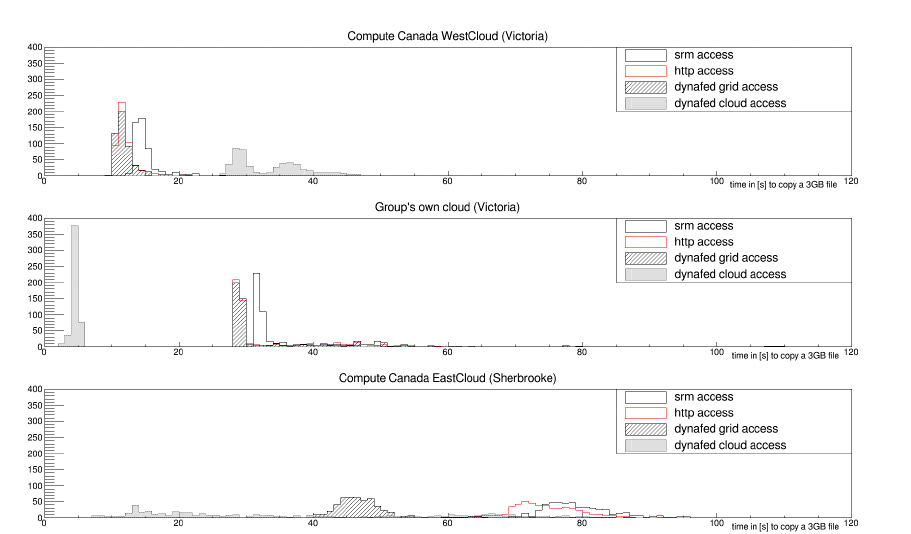
Figure 6: Time distribution for copying 500 3GB files with access through Dynafed using object stores as endpoints behind Dynafed (gray dotted histogram); initiated by clients on di ff erent clouds and in addition to previous test